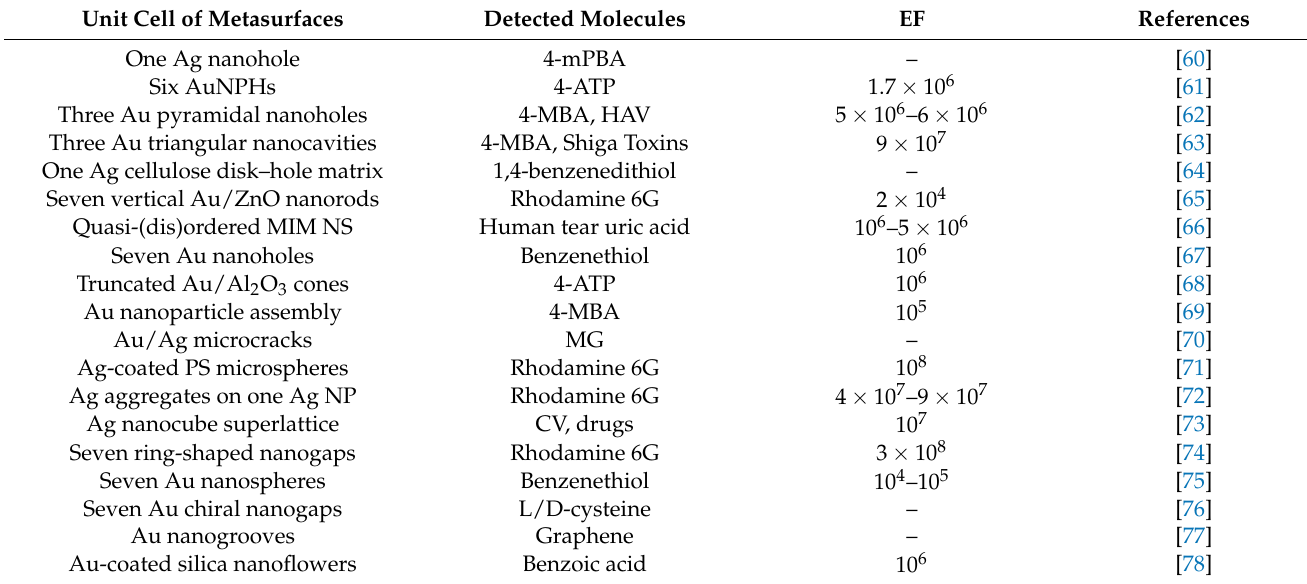
Table 1. Unit cell of metasurfaces, detected molecules and the enhancement factor (EF) for surface- enhanced Raman scattering sensors (4-mPBA = 4-mercaptoPhenylBoronic Acid; AuNPHs =